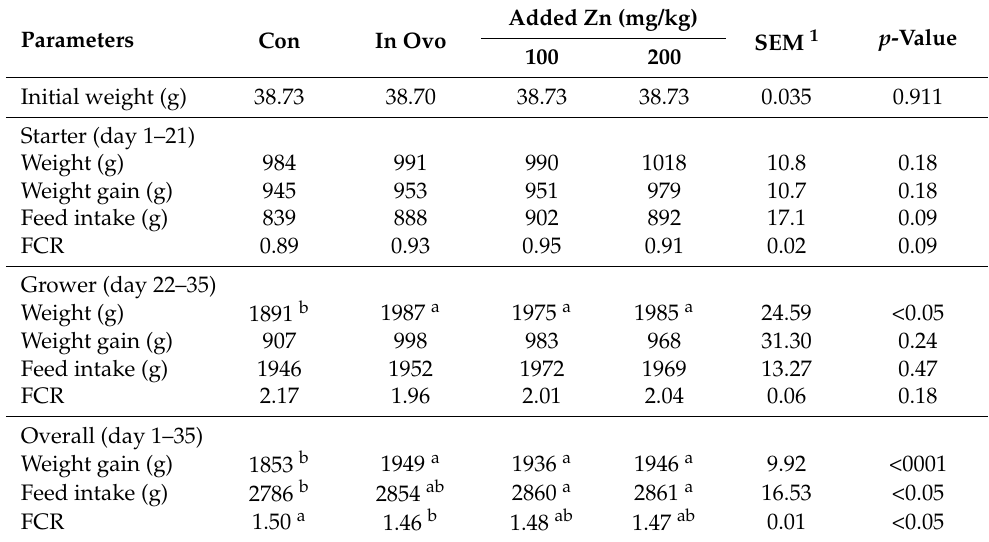
Table 2. Effect of in ovo injected and supplemental Zn on growth performance in broilers at 35 days of age.